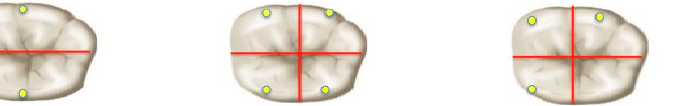
Figure 2. Scheme of the study design.